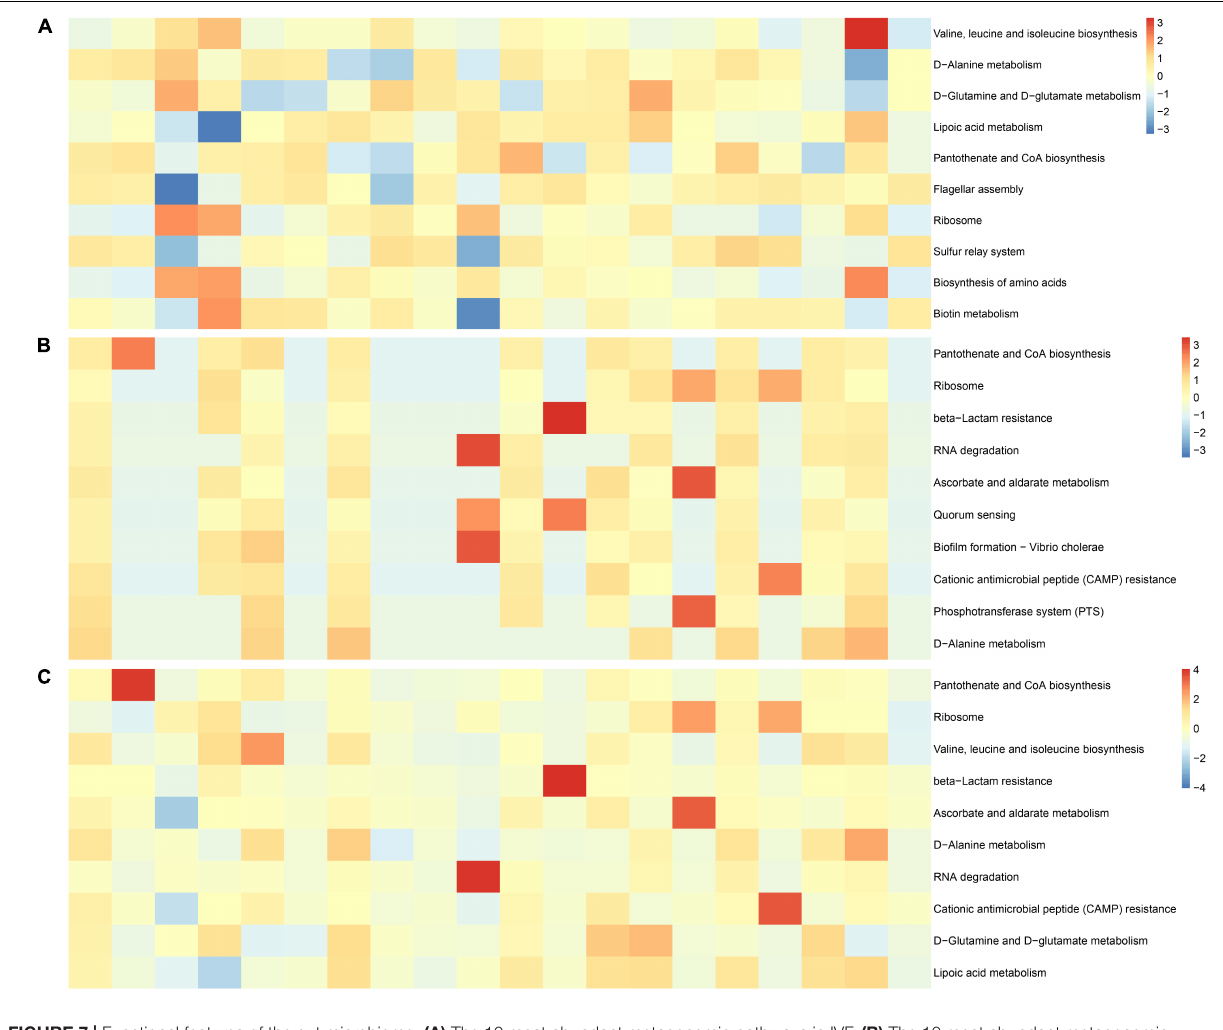
FIGURE 7 | Functional features of the gut microbiome. (A) The 10 most abundant metagenomic pathways in IVF. (B) The 10 most abundant metagenomic pathways in tissue. (C) The 10 most abundant metagenomic pathways in the two groups. The heatmap is converted from standardized data and